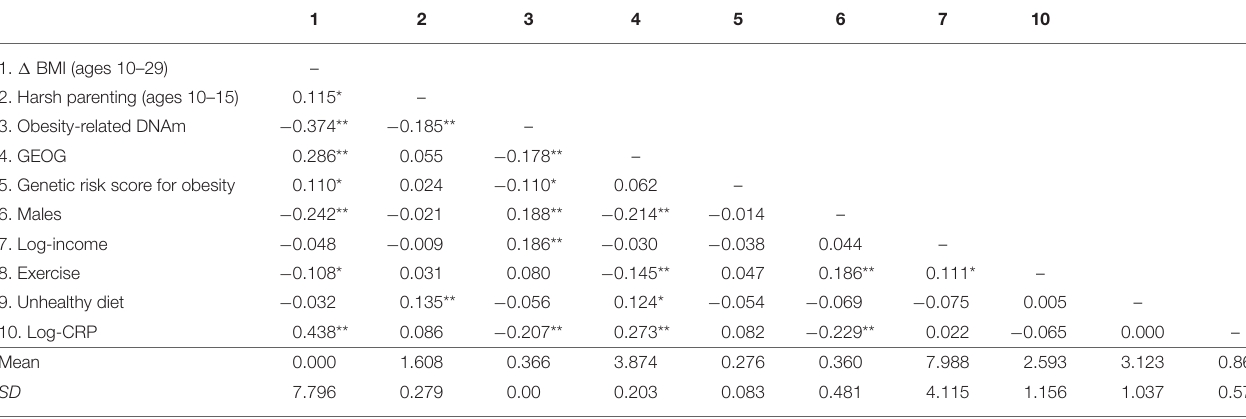
TABLE 1 | Correlations, means, and standard deviations among study variables ( N = 362). 1